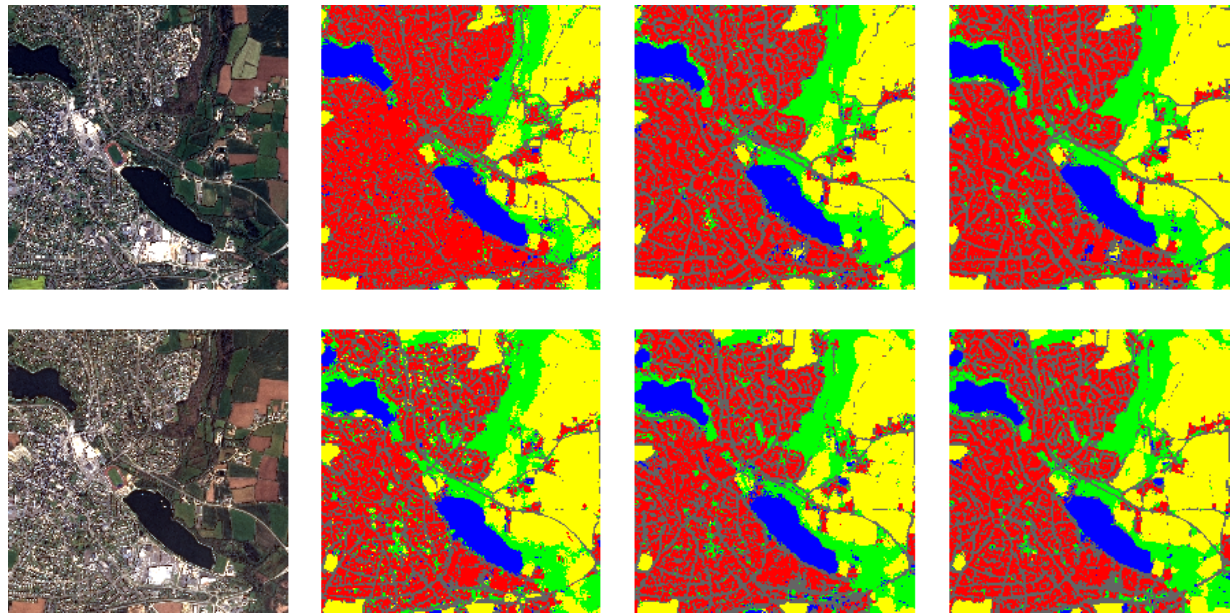
Figure 6. Illustration of the changes of the learning strategies over a small part of ROI-1. Top row: 2014 data. From left to right: 2014 image, M 2 2014 , M 2 2000 1 − 2014 , M 2 8000 1 − 2014 . Bottom row: 2016 data. From left to right: 2016 image, M 1 2014 , M 2 2000 1 − 2016 , M 2 8000 1 − 2014